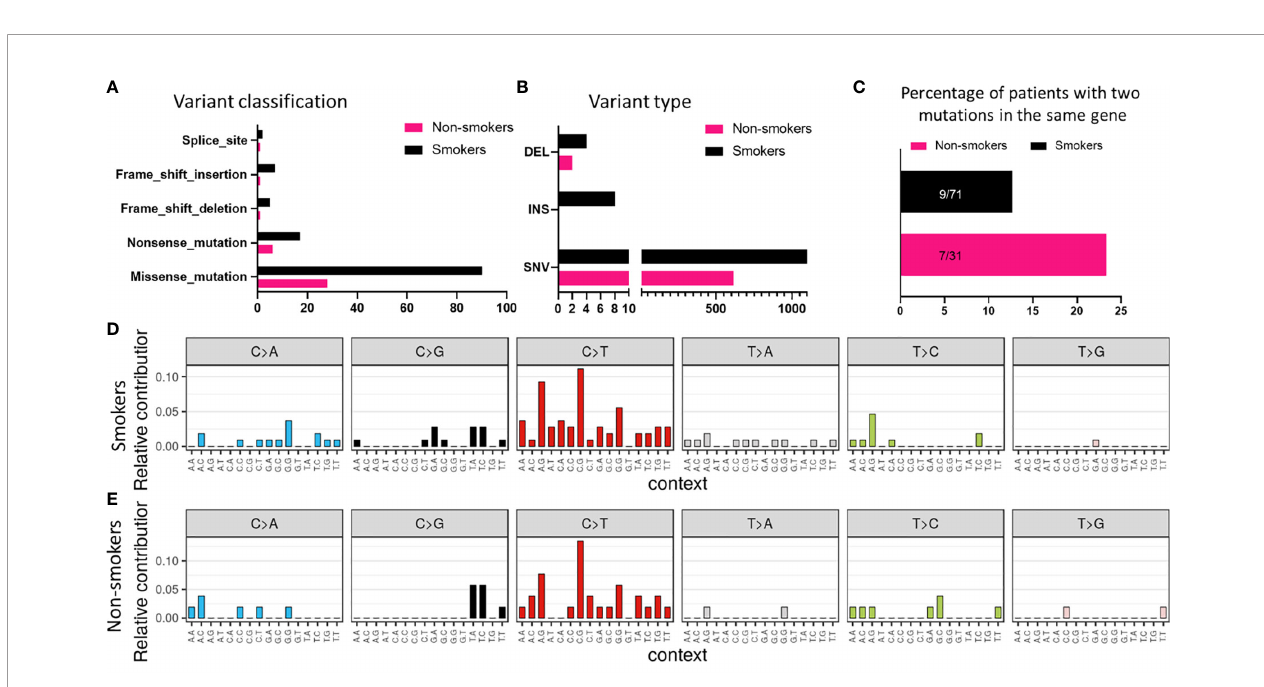
FIGURE 4 | Mutational signature associated with smokers and non-smokers based on (A) variant classi fi cation, and (B) variant type. (C) Comparison of number of patients with two or more mutations in the same gene based on smoking status. Mutational pro fi le based on C:G>T:A transitions in (D) smokers and (E)